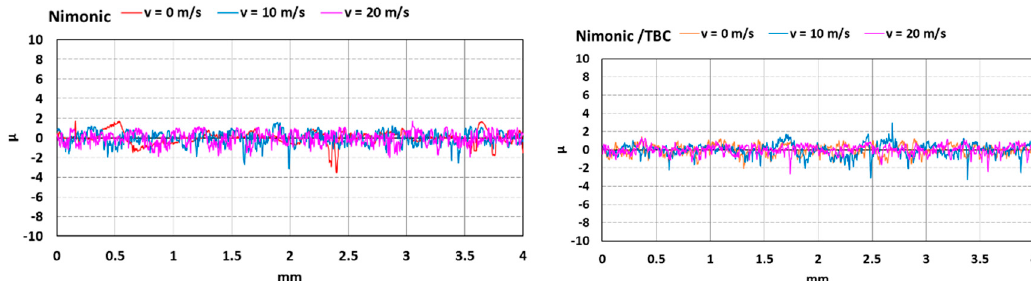
Figure 9. Surface roughness investigations of uncoated and coated Nimonic 80A substrate.